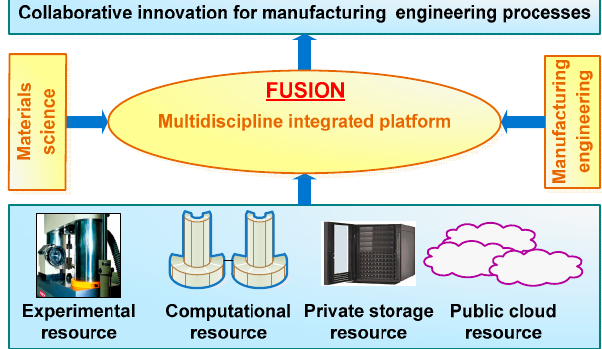
Figure 3. Logical diagram of a multidiscipline platform for collaborative innovation.